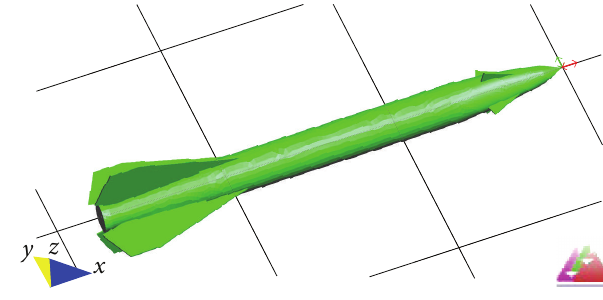
Figure 9: Model of Mirage aircraft.